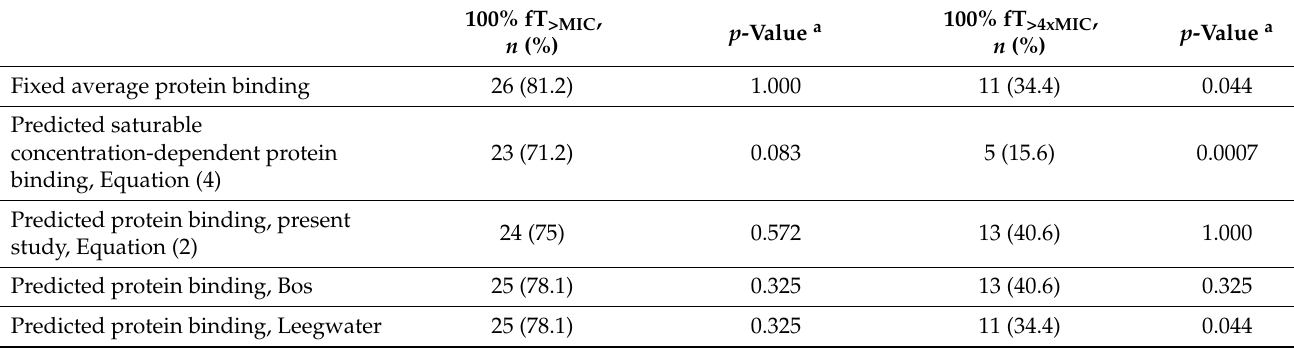
Table 3. Agreement for PK/PD target attainment based on measured and predicted unbound concentration of